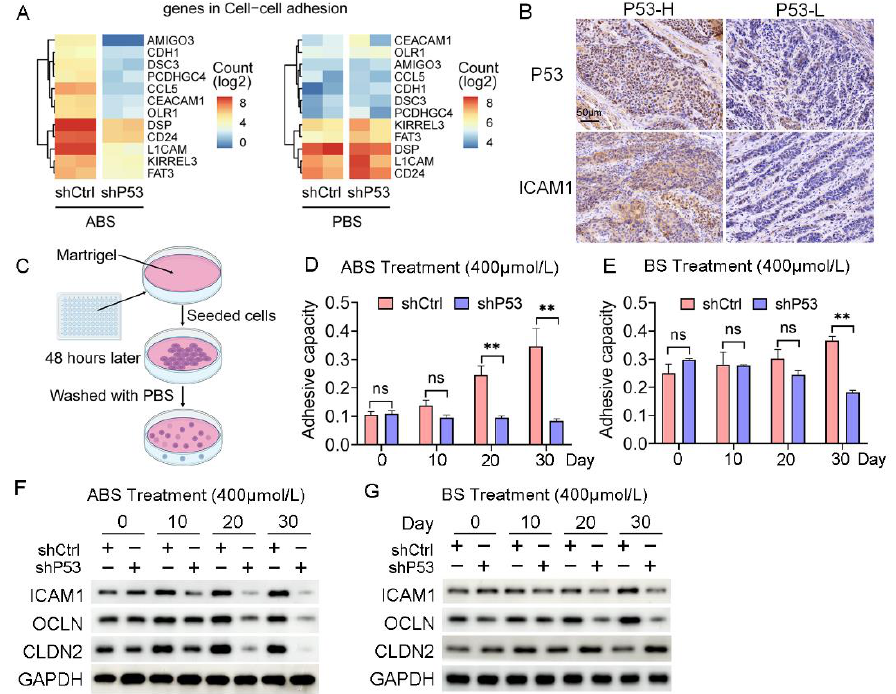
Figure 4. P53 dependence of bile acid-induced cell adhesion. ( A ) Heatmap of gene expression in cell adhesion pathway after exposure to ABS (left) and PBS (right) of P53 knockdown and control group. ( B ) Representative images of P53 and ICAM1 IHC staining. ( C ) Schematic outline of cell adhesion assay. ( D ) Quantification of cell adhesion capacity of HET1A cell with or without P53 knockdown after ABS treatment. ( E ) Quantification of cell adhesion capacity of HET1A cell with or without P53 knockdown after BS treatment. ( F ) The expression levels of cell adhesion markers ICAM 1, OCLN and CLDN2 after continuous exposure to ABS. ( G ) The expression levels of cell adhesion markers ICAM1 , OCLN and CLDN2 after continuous exposure to BS. +: Treated accordingly; − : Not treated accordingly. Data were statistically analyzed using the student t -test. ** p < 0.01, ns: none